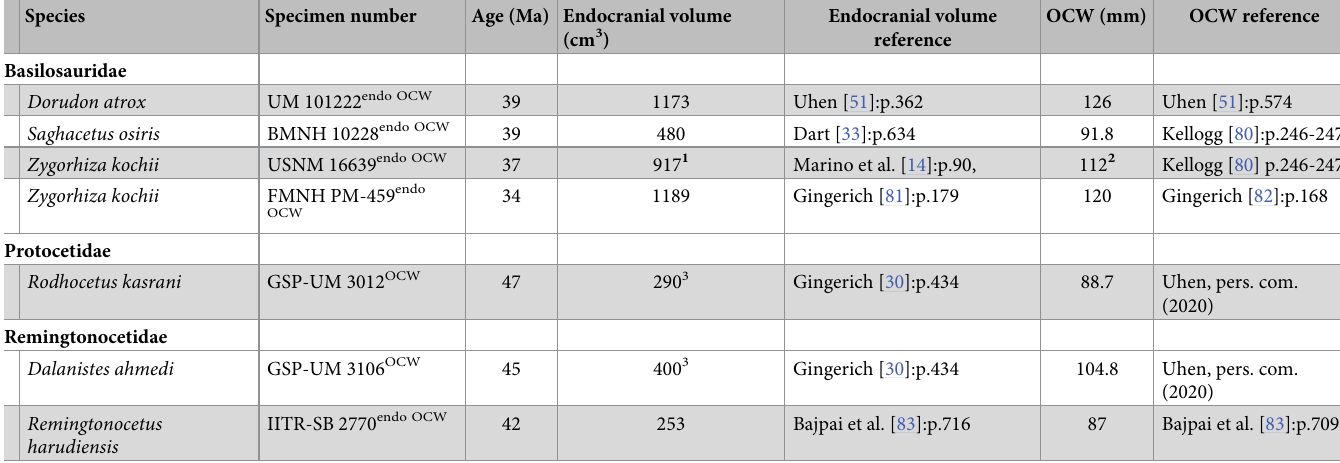
Table 2. Eocene cetaceans included in this